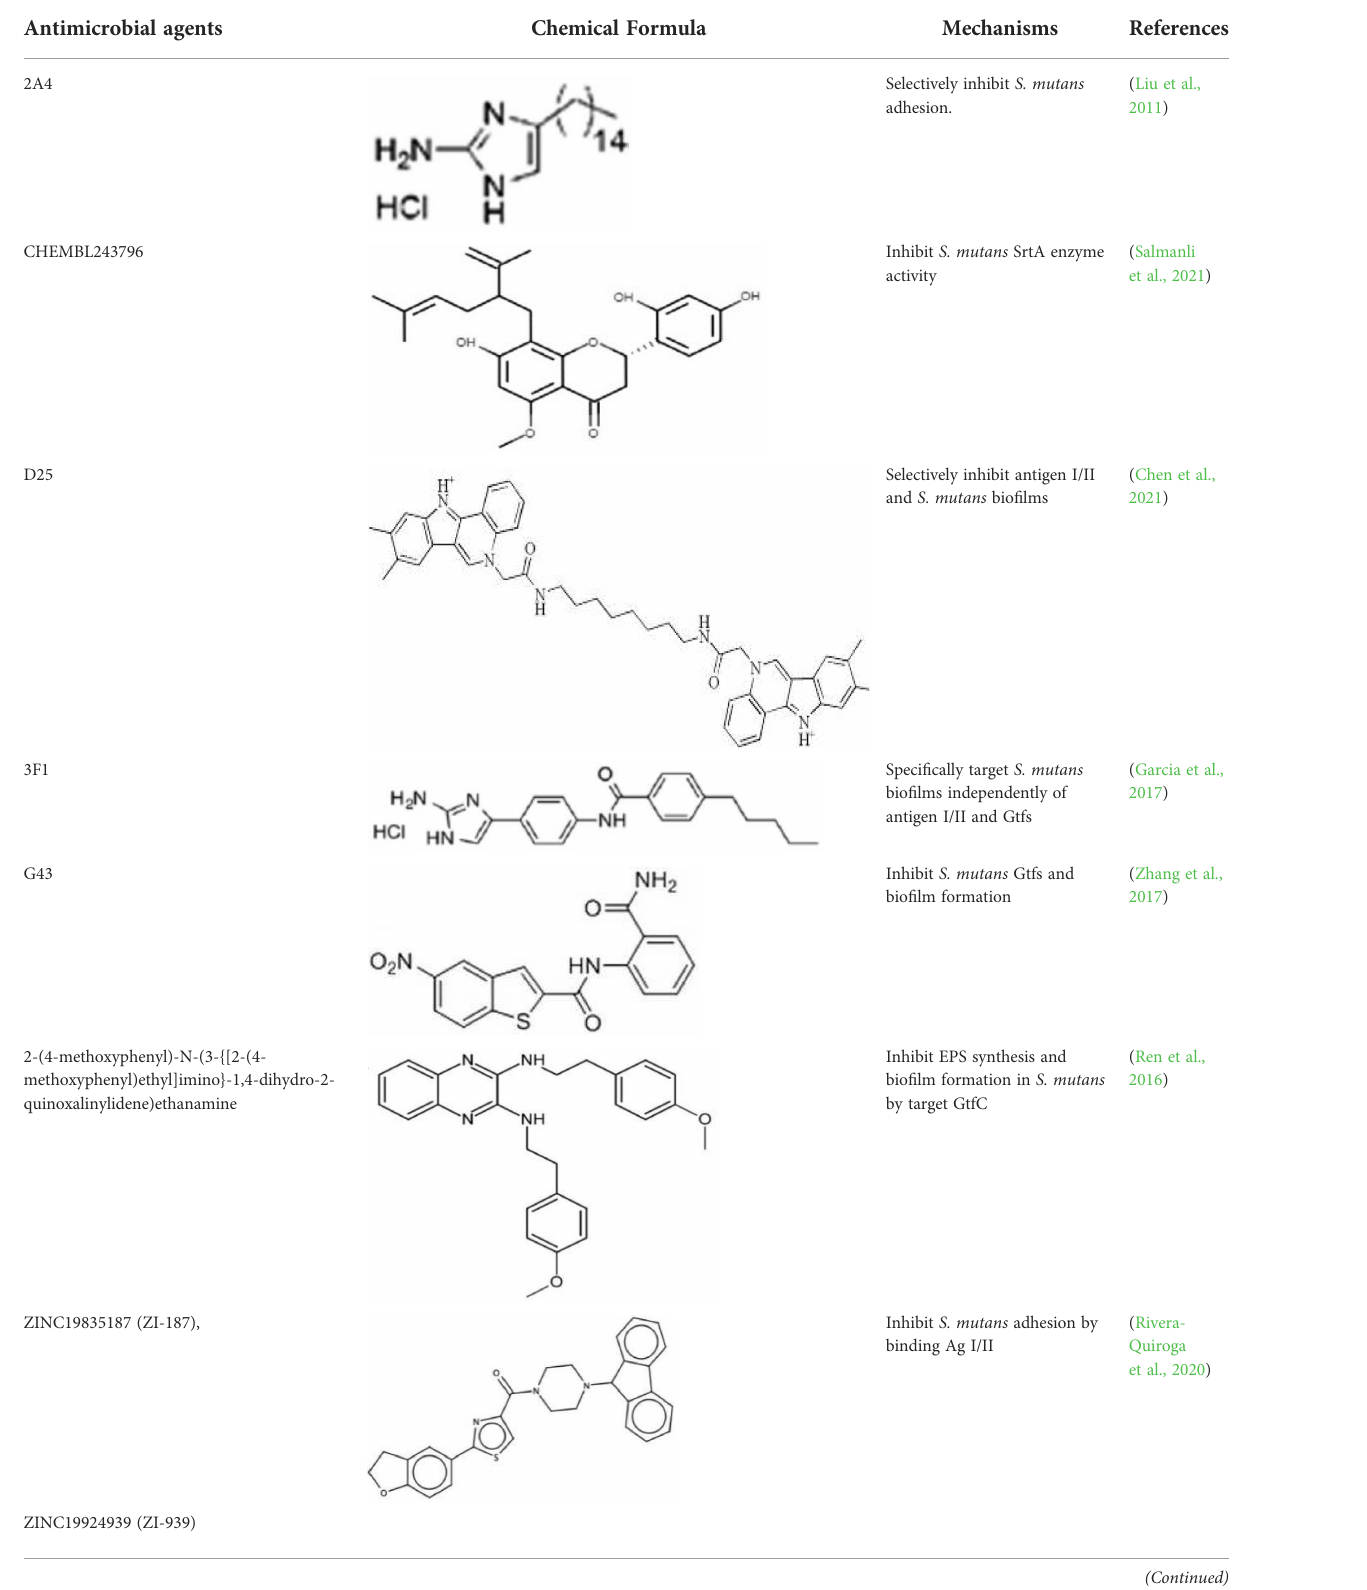
TABLE 1 Progress in computer-aided drug design (CADD) towards S.mutans